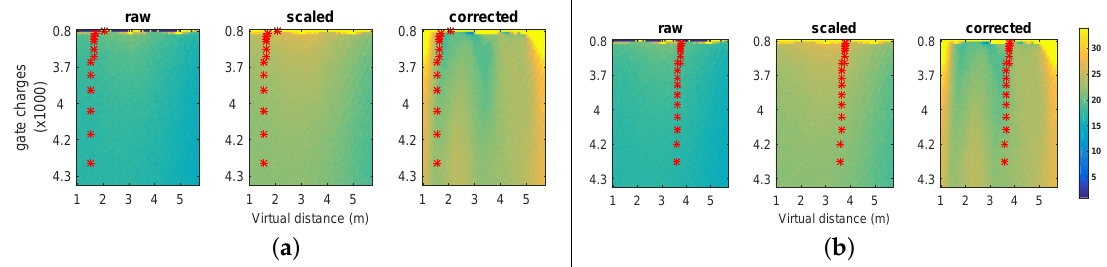
Figure 14. 2D SD diagrams for the raw, the linearly mapped and the calibrated data (left to right). The red dots indicate the location of some of the rail measurements in the distance-intensity plane for the initial operation range ( a )) and the shifted operation range ( b ). ( a ) 2D SD diagrams for standard operation range; ( b ) 2D SD diagrams for shifted operation